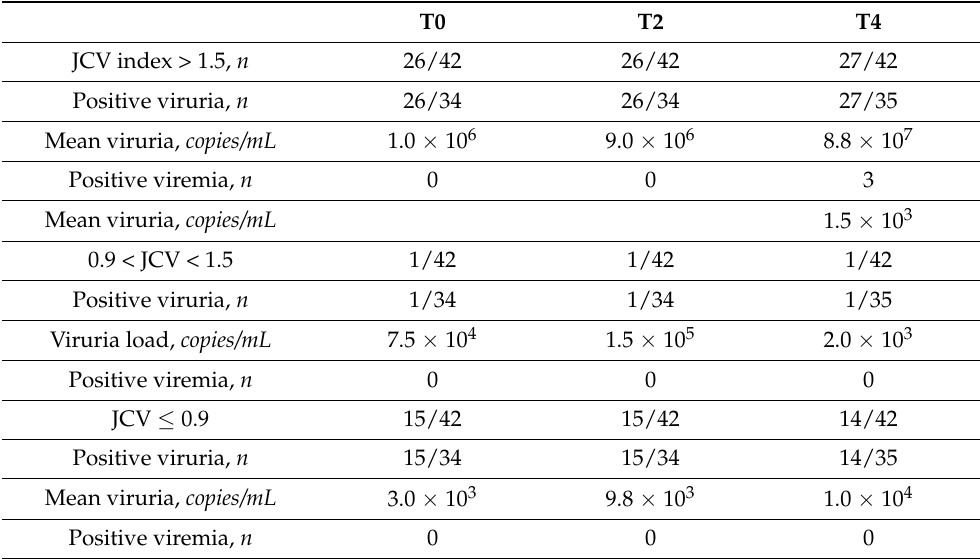
Table 5. Analysis of viruria and viremia in patients with an anti-JCV index >1.5, 0.9 < JCV < 1.5 and